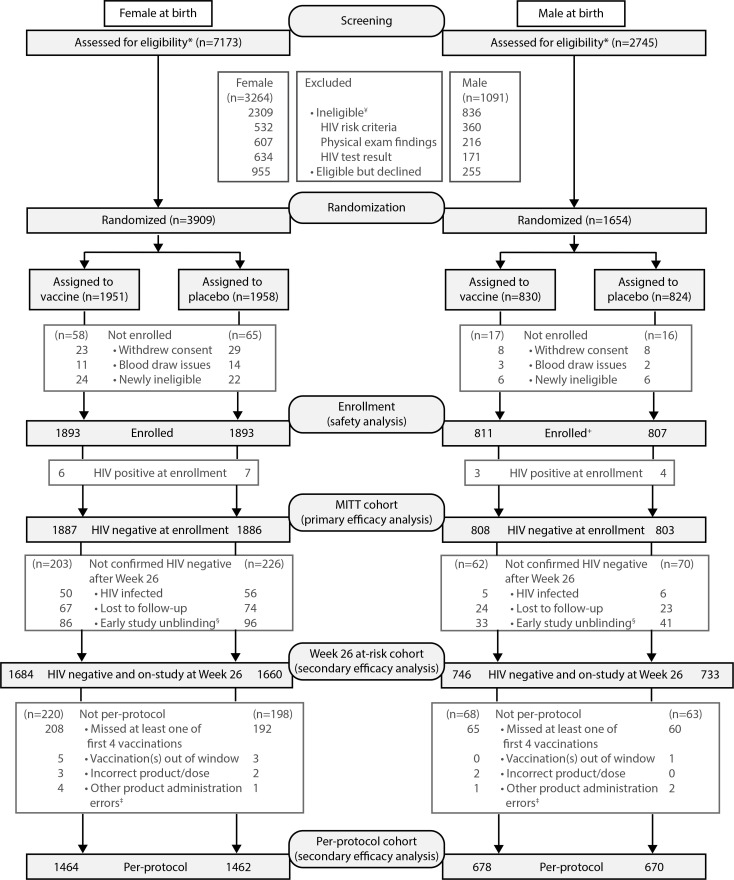
Screening, randomization, enrollment, and study outcomes.
¥Top 3 reasons for ineligibility shown.
*4 participants were screened and found ineligible
but sex-at-birth not recorded. +3 participants were
randomized and enrolled twice and only data from the first randomization
and enrollment is considered. §Participant is not in
Month 6.5 at-risk cohort because no HIV diagnostic test was performed
after Month 6.5 and prior to study unblinding. ‡Other
product administration errors include incorrect site of administration,
product expired, and other.